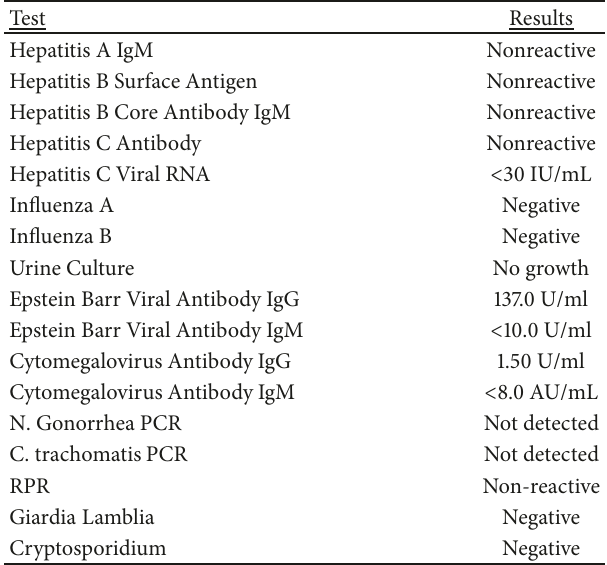
Table 1: Infectious disease